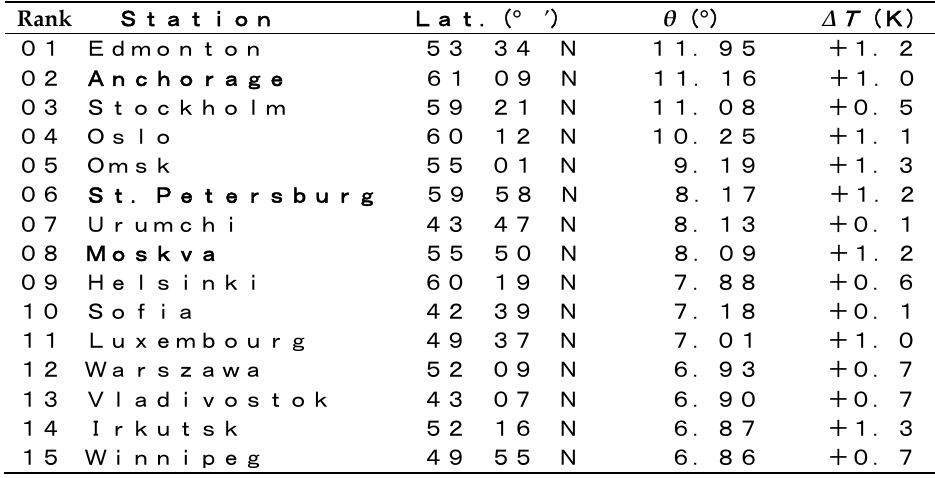
∆ T indicates the increment of the mean temperature from the former to the latter period. Table 2. Top ‐ thirty Northern Hemispheric stations in the rotation angle of the monthly distributions of temperatures from Period II (1951 ‐ 1980) to III (1981 ‐ 2010). Rank